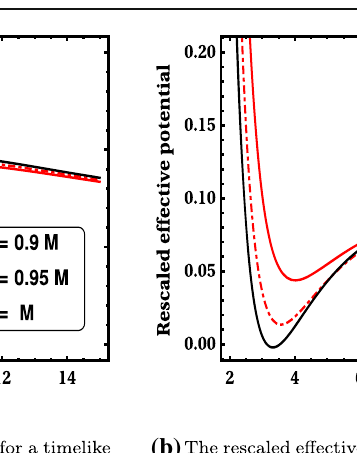
to ˜ L = 3 . 7 M . In both these plots, the NUT charge, Carter constant and blackholerotationparametersaretakentobeidentical.Theplotsexplic- itly depict presence of circular orbits, given the existence of minima of the